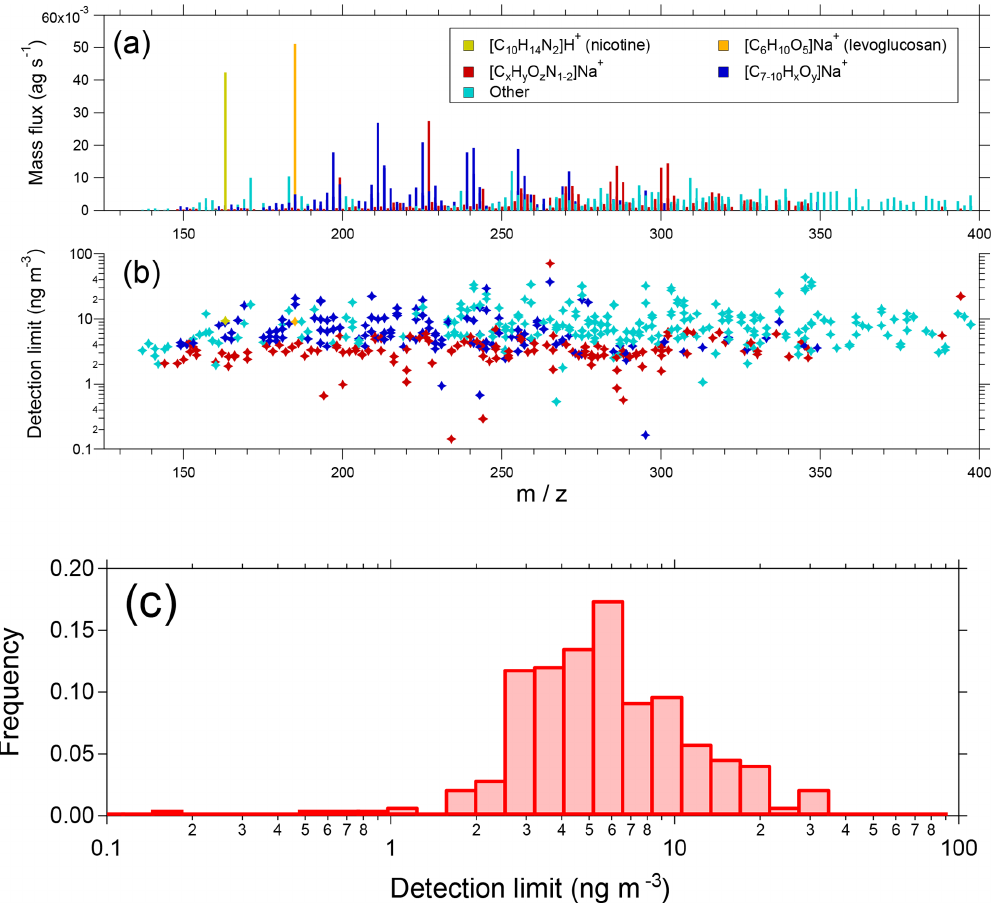
Figure 10. (a) Campaign average EESI-TOF mass spectrum from summer measurements in Zurich, Switzerland. Selected ions and families are colored as shown in the legend. Note the x axis begins at m/z 125 due to blanking of smaller ions by the quadrupole ion guides. (b) Campaign median detection limits (30s), colored as in Fig. 10a. Detection limits are calculated as 3 σ variation of the filter blank periods flanking a direct sampling interval and assuming a uniform sensitivity of 1450Hz(µgm − 3 ) − 1 . (c) Probability distribution of campaign median detection